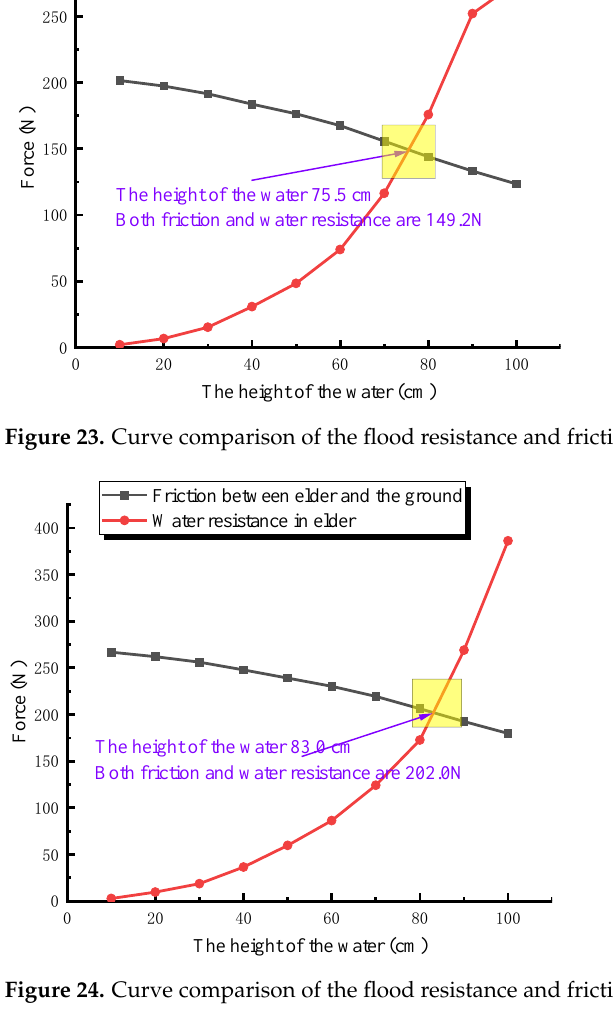
Figure 24. Curve comparison of the flood resistance and friction (elder).